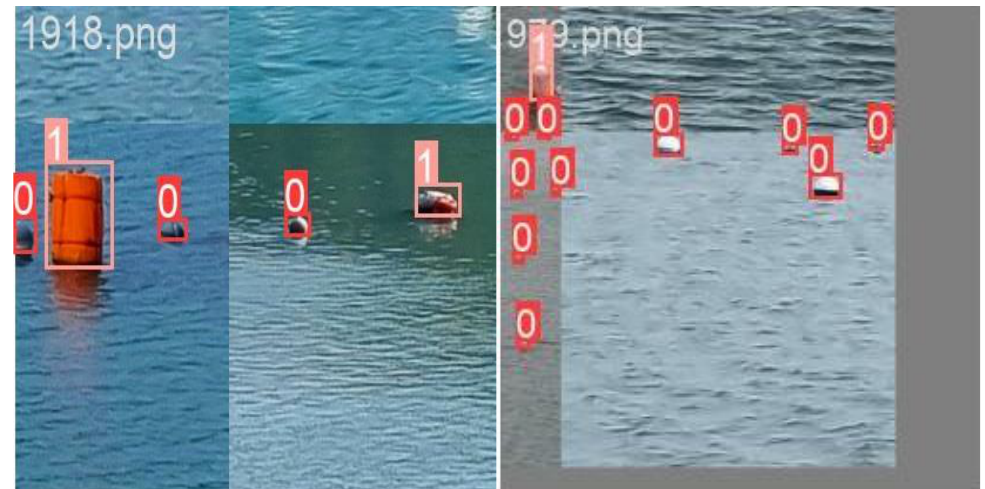
10 of 22 Figure 8. Learning data. 3.1.2. Mosaic Augmentation Mosaic augmentation was used to train the model because the sizes of buoys in the training data are relatively small, making them difficult to detect. The main idea is to